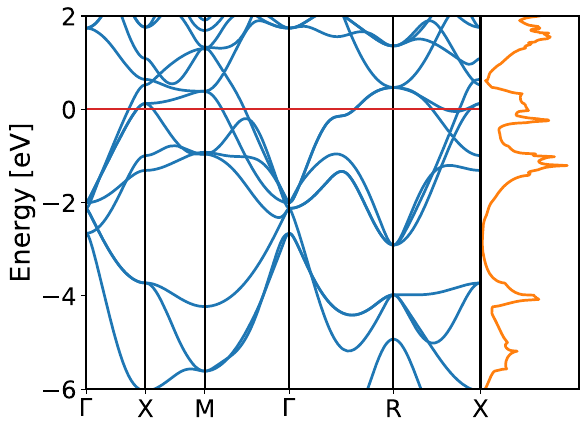
Fig. 8 Calculated band structure (left) and total density-of-states (right) for AsHTi 3 . The red line represents the Fermi